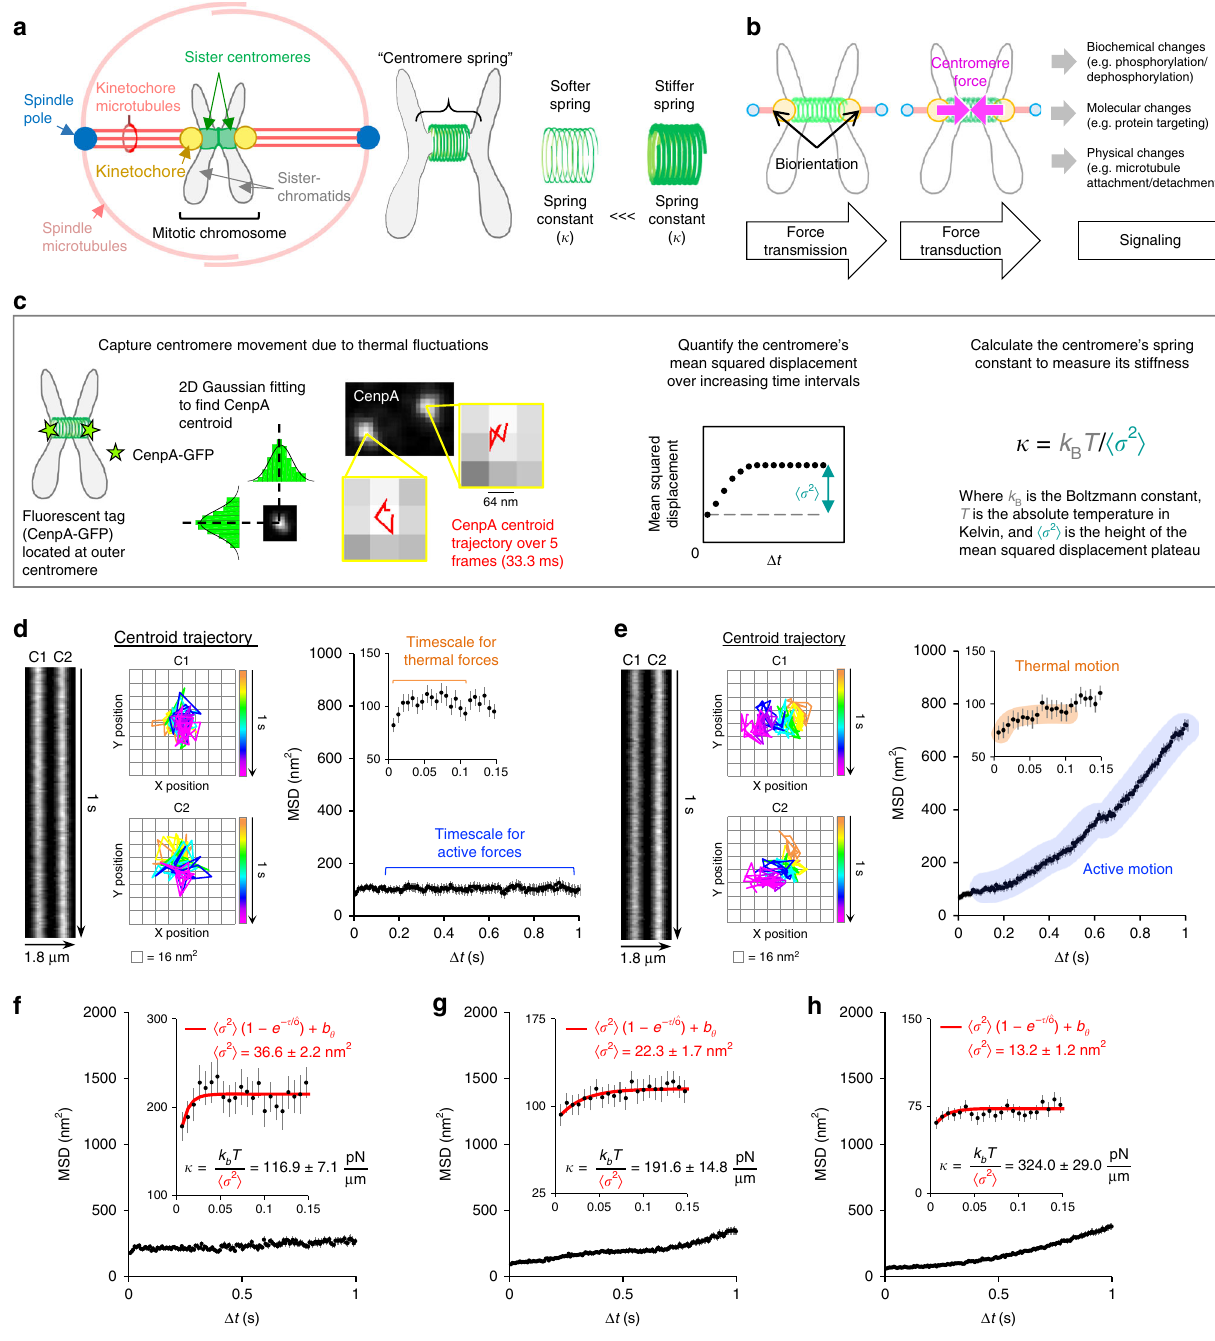
Fig. 1 Optical assay to estimate the stiffness of the centromere-spring in human cells. a Each condensed mitotic chromosome (black outline, left) consists of two duplicate sister chromatids (gray, left) that are mechanically linked between the sister centromeres by the centromere-spring (green, center). The centromere- spring includes the material from the outer centromere on one sister chromatid to the outer centromere on the other (green, center). The centromere-spring ’ s inherent stiffness is quanti fi ed through its spring constant (right). b Biorientation creates a spatial separation between sister centromeres and generates centromere tension (left), which triggers biochemical, molecular, and physical changes at the centromere, kinetochore, and kinetochore microtubules (right). c Optical assay to measure centromere-spring stiffness. Left: Centromere movement is captured via high-resolution imaging of a fl uorescent tag (CenpA-GFP) on two sister chromatids. 2D Gaussian mixture model fi tting locates CenpA-GFP tags with nanometer precision, while rapid image acquisition isolates movement due to thermal fl uctuations. Red trajectories show the centroid movement over the fi rst 5 frames of 300 frames for each CenpA tag. Center: The MSD of the CenpA tag is calculated for increasing time intervals to yield the net MSD ( σ 2 ). Right: Boltzmann ’ s Law divides the thermal energy (numerator) by the net MSD of the CenpA tag ( σ 2 , denominator) to calculate the spring constant of the centromere-spring ( κ ), which quanti fi es its stiffness. d , e Data from the Centromere Motion Tracking Protocol for two representative chromosomes. Left: Kymographs showing how CenpA-GFP tags on sister centromeres (C1, C2) change over 1s (150 frames). Center: Trajectories for each CenpA-GFP centroid over 1s. Right: MSD plots demonstrating the timescale for active, directed motion at longer time intervals (up to 1s), as compared to the timescale for diffusive thermal fl uctuations (inset). f – h MSD plots for three chromosomes that represent the range in derived spring constant values for the centromere-spring in RPE-1 cells. Insets: MSD data over the timescale for thermal fl uctuations. The nonlinear regression fi t of the MSD data at time intervals below 0.15s to the equation for constrained motion is shown in red. All error bars represent standard error. See also Supplementary Fig. 1 NATURE COMMUNICATIONS| (2019) 10:1761